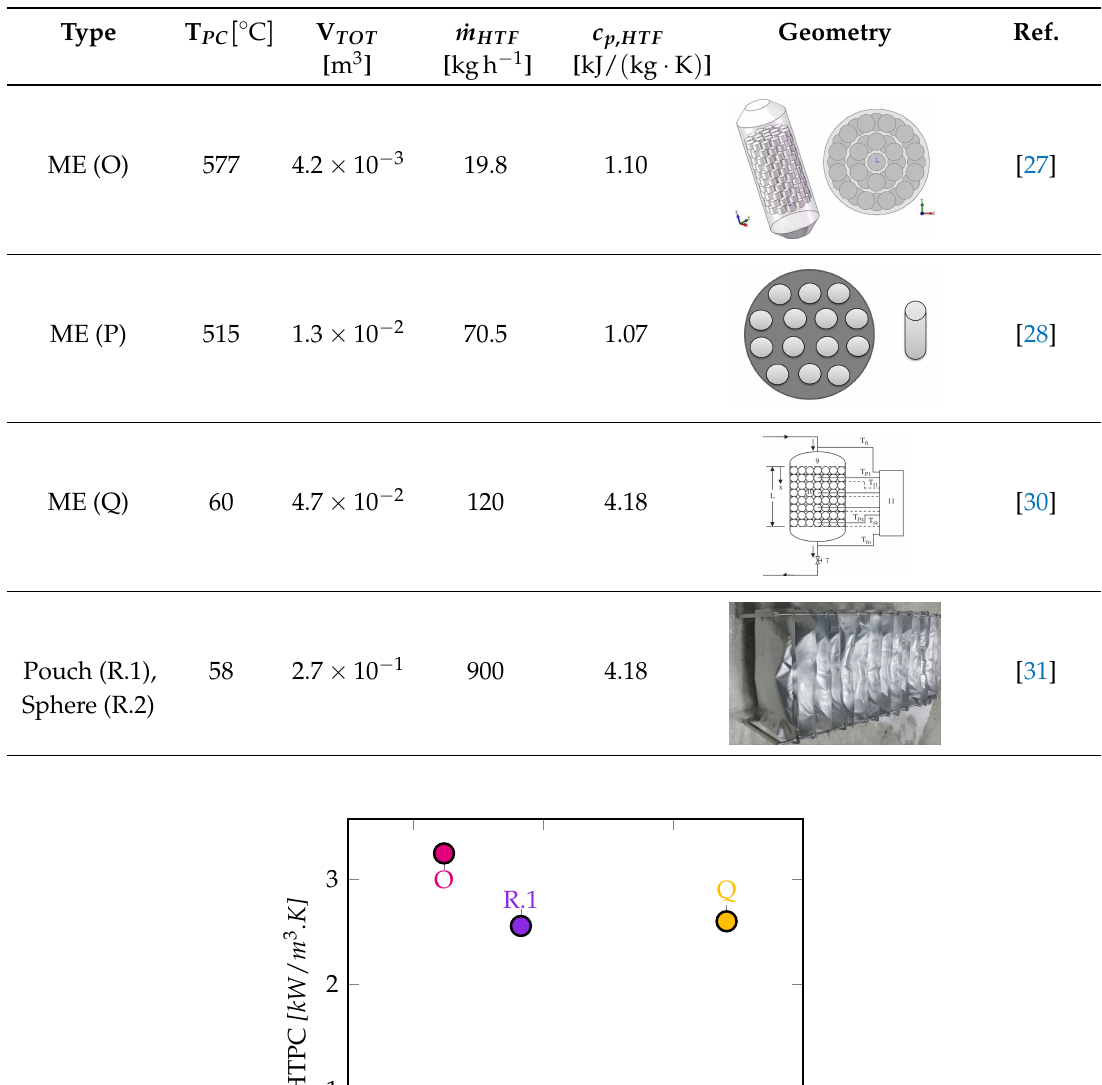
Table 4. References pertaining to macro encapsulation techniques.